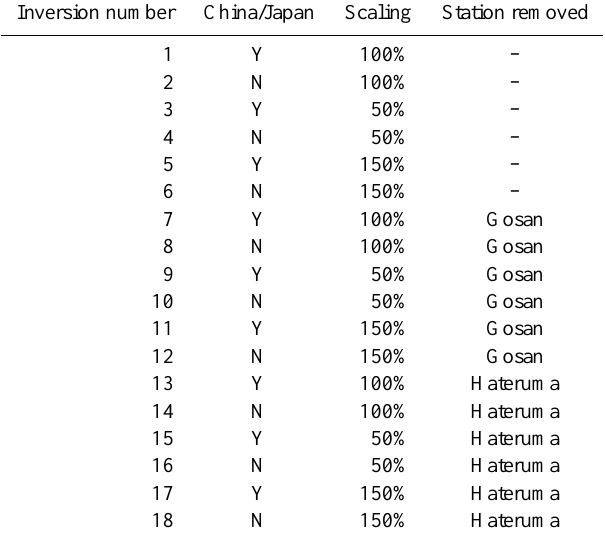
Table 2. Ensemble of 18 inversions used to quantify the uncertainty of the a posteriori emissions. “China/Japan” indicates whether the special information available for these countries was used (“Y”), or not (“N”). “Scaling” indicates how reference emissions have been scaled, and “Station removed” indicates which data set has been removed from the